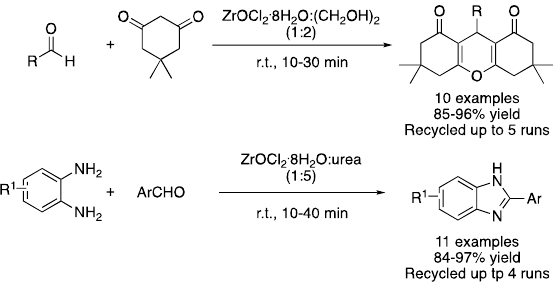
Figure 15. Cyclizations using Zr-based type IV DESs.